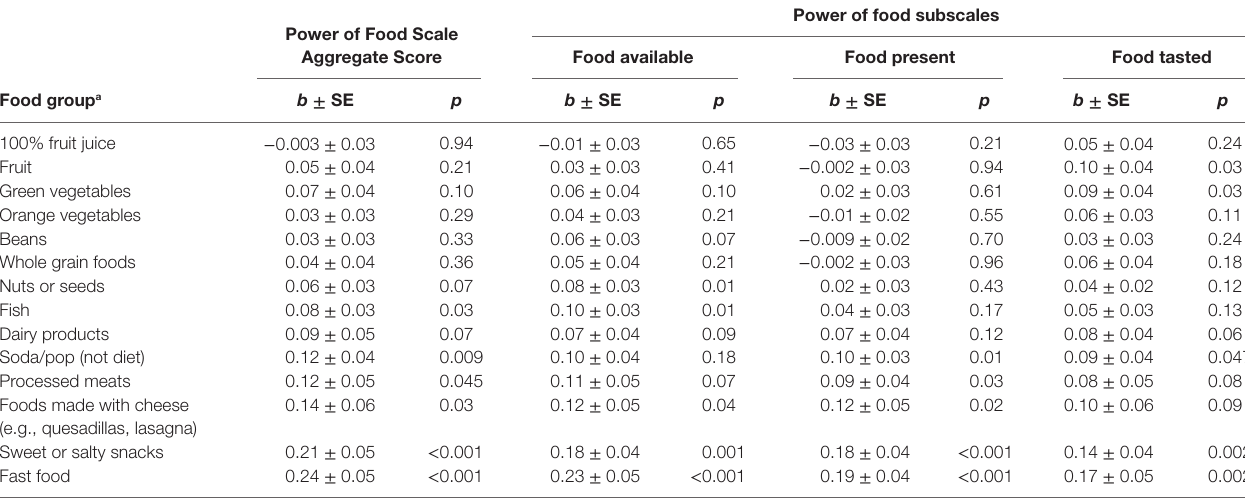
TaBle 2 | linear regression models estimating associations of food reward responsivity with intake frequency. Power of food subscales Power of Food scale aggregate score Food